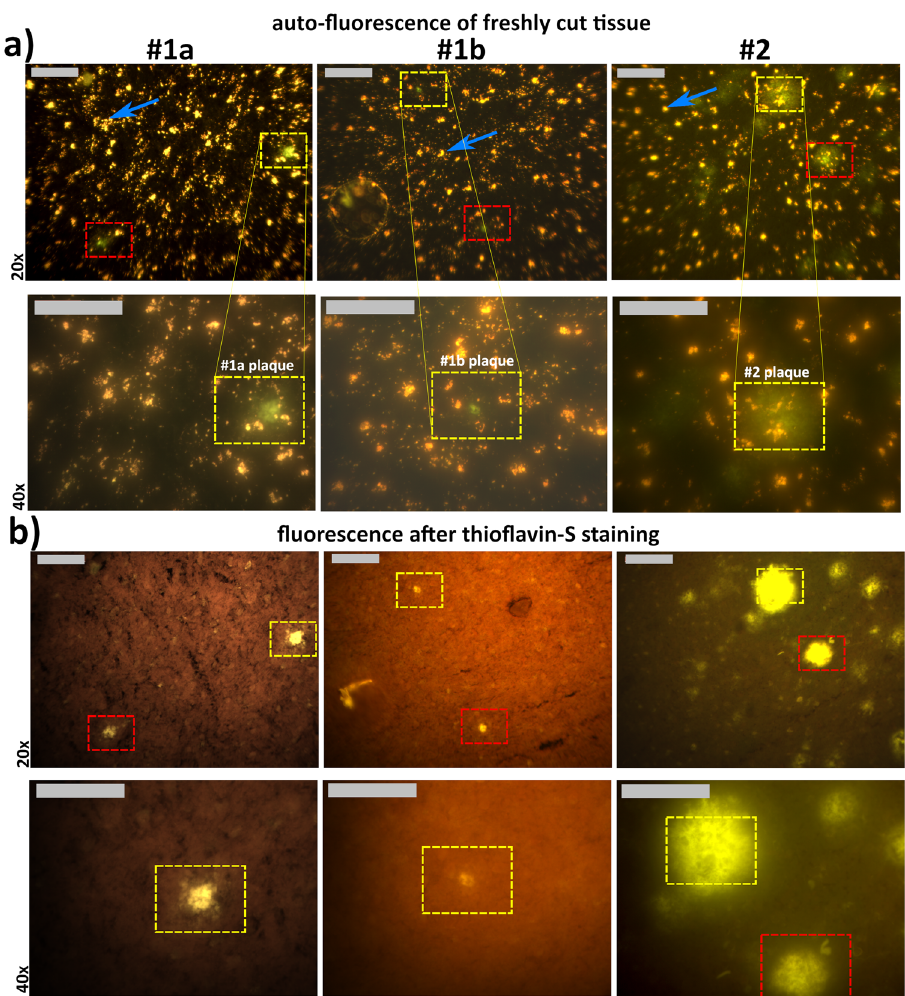
Fig. 2 Fluorescence images of AD cases 1 and 2, before and after staining, at ×20 and ×40 magni fi cation. a Auto- fl uorescence images of freshly cut tissue. Greenish dense cores (#1a and #1b) and greenish patches (#2) are clearly visible. The uniformly distributed yellow spots (blue arrows, just one is identi fi ed in each image) are lipofuscin deposits 23 . b Fluorescence images of the same tissue sections and areas stained with thio fl avin-S. Here, the yellow bright spot areas are the positively stained amyloid accumulations. All images were taken with the full- fi eld fl uorescence microscope and an illumination source of 470 nm. Yellow and red dashed boxes mark the measured plaque areas. # refers to AD donor number and plaque in Table 1. Scale bars: 100 µ m. The ×40 image pairs of the red dashed boxes are shown in the Supplementary Information, Fig. S2. Enlarged images of each plaques are shown in Fig. 3. The image pairs of cases 3 – 5 are shown in Fig.